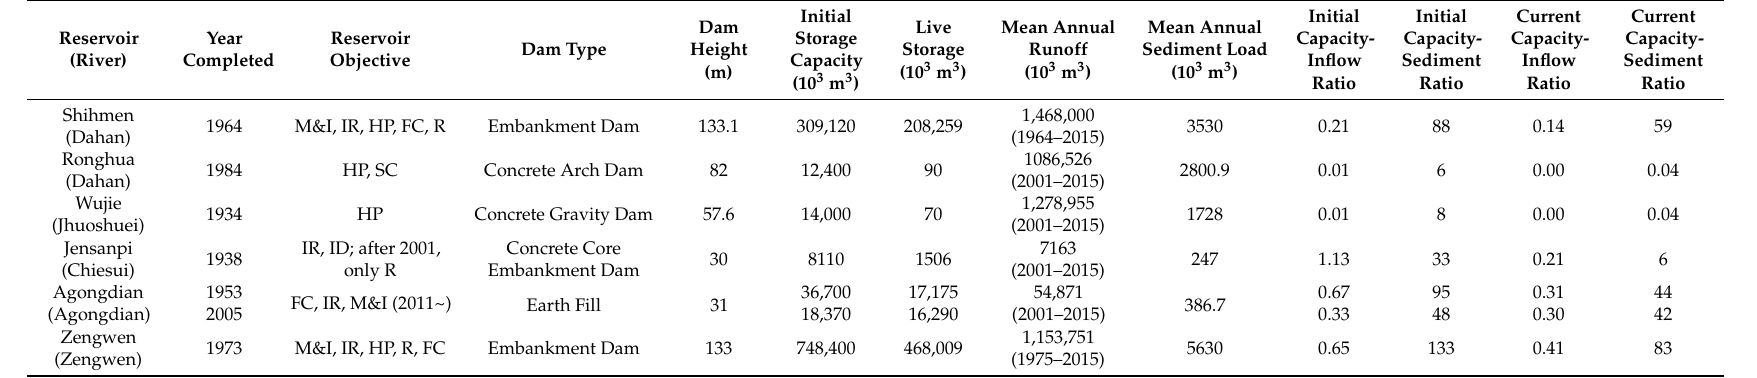
Table 3. Overview of case studies (data courtesy of WRA, Taipower Company, and Taiwan Sugar Corporation). Reservoir Objectives are defined as Municipal and Industrial (M&I), Irrigation (IR), Industrial (ID), Hydropower generation (HP), Recreation (R), Sediment Control (SC), and Flood Control